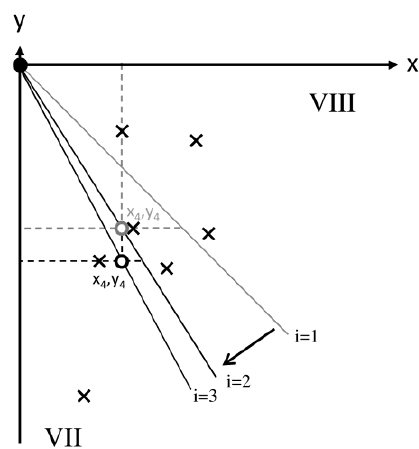
Figure 2. Principle of the quadrant based search for the window outline.